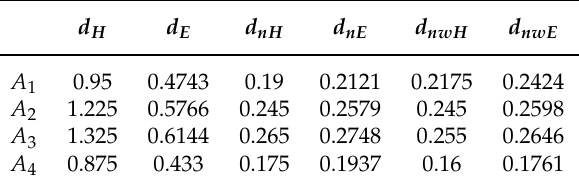
Table 2. Distance results.